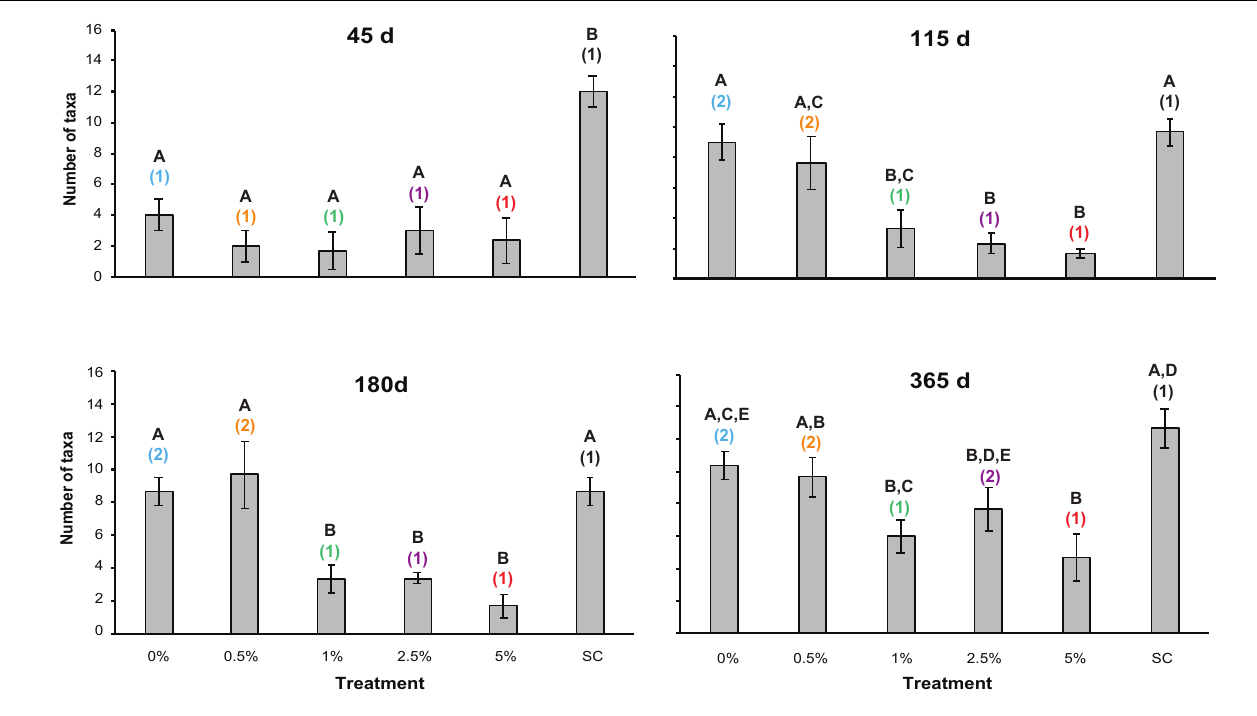
FIGURE 6 | Mean number of taxa (per 0.008 m 2 core) in the different treatments over time. Errors bars denote ± 1 standard error of the mean ( n = 3). Different letters denote significant differences ( p < 0.05) between the means of the treatments at each sampling point. Different colored numbers denote significant differences ( p < 0.05) between the means of a specific treatment at different sampling times. Colors used for the different treatments are the same as used in Figure 2 to aid clarity.